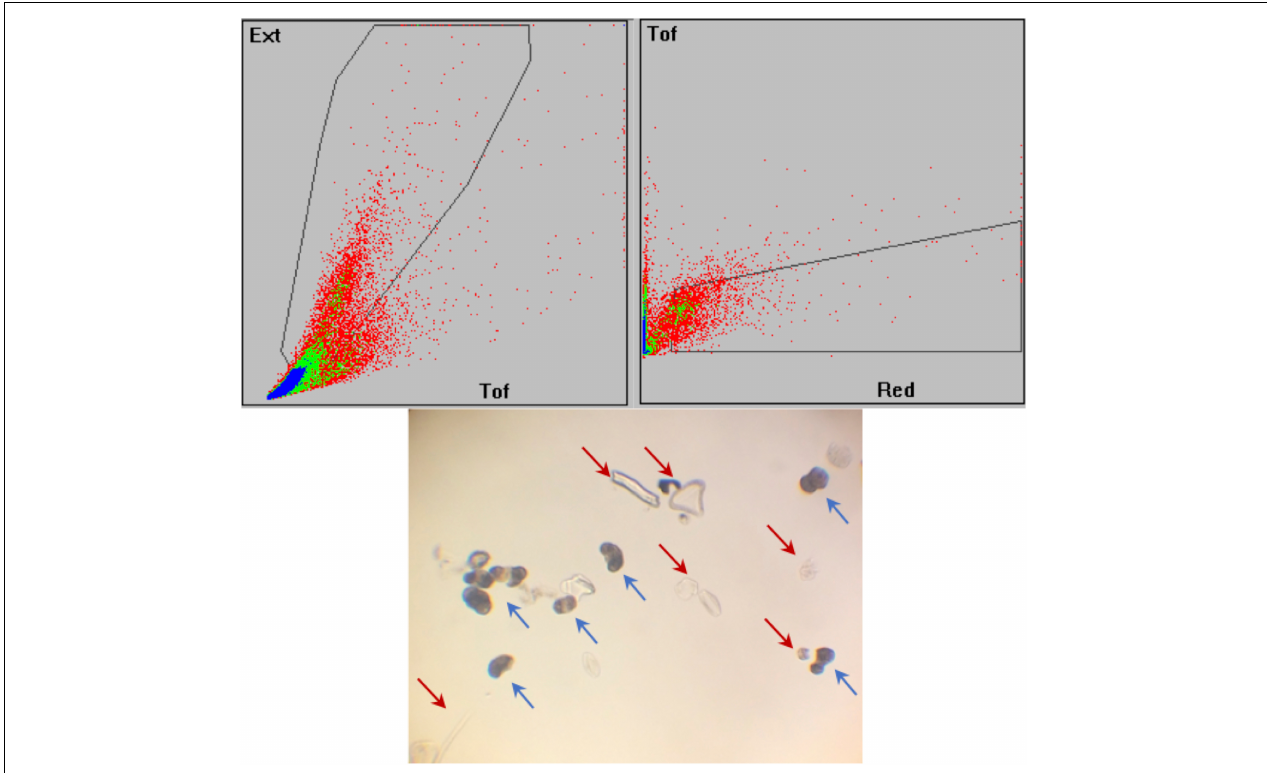
FIGURE 3 | Flow cytometry plots of sample 1D-5U-2-46, as an example of the gates used to separate the pollen grains. The gates are the black polygons, showing the selected areas in which the ideal particles are included; each dot represents a particle that traveled through the COPAS laser. The gates are drawn by the operator based on optical density (Ext = extinction), size (Tof, time of flight), and fluorescence (Red). Photograph below shows the 1D-5U-2-46 sample after extraction and before sorting. The blue arrows indicate some examples of pollen grains, while the red arrows point out non-pollen particles, such as diatoms and organic fragments, that survived chemical digestion and sieving during pollen